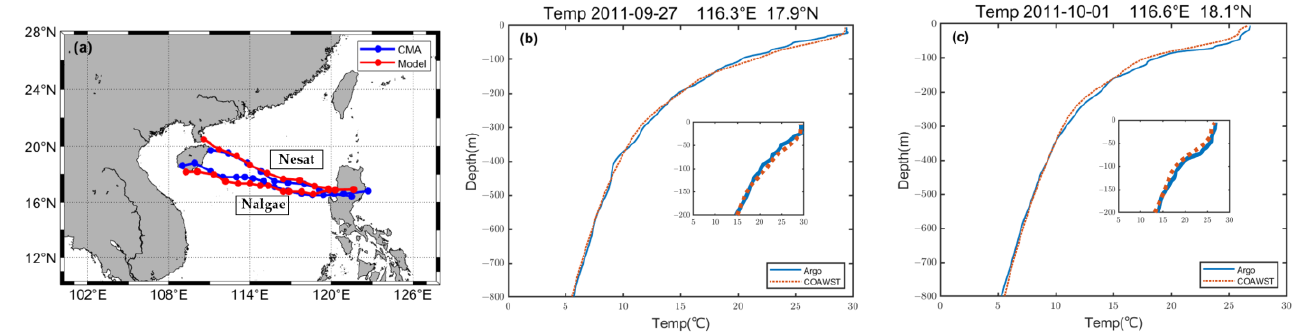
Figure 1. Comparison between simulated data and observed data: ( a ) Moving track; ( b ) 27 September temperature profile; ( c ) 1 October temperature profile.